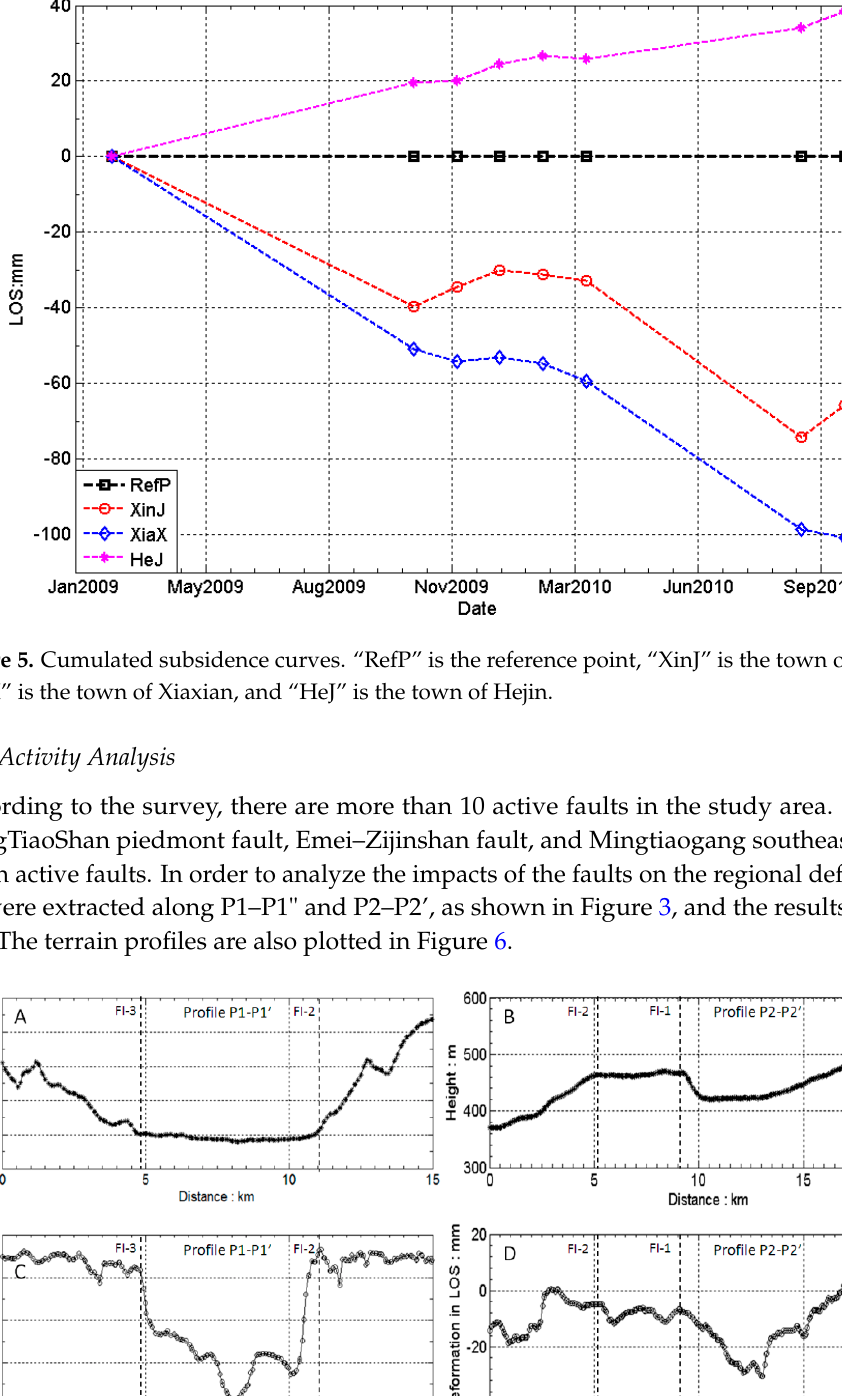
Figure 4. Correlation between ground deformation and terrain: ( A ) area A Figure 3; and ( B ) area B in Figure 3.